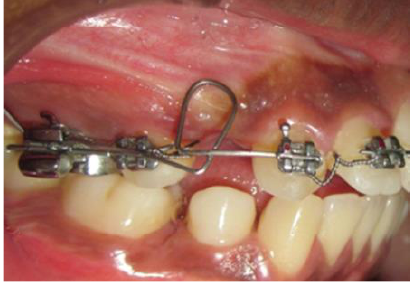
Figure 15: Modified Marcotte